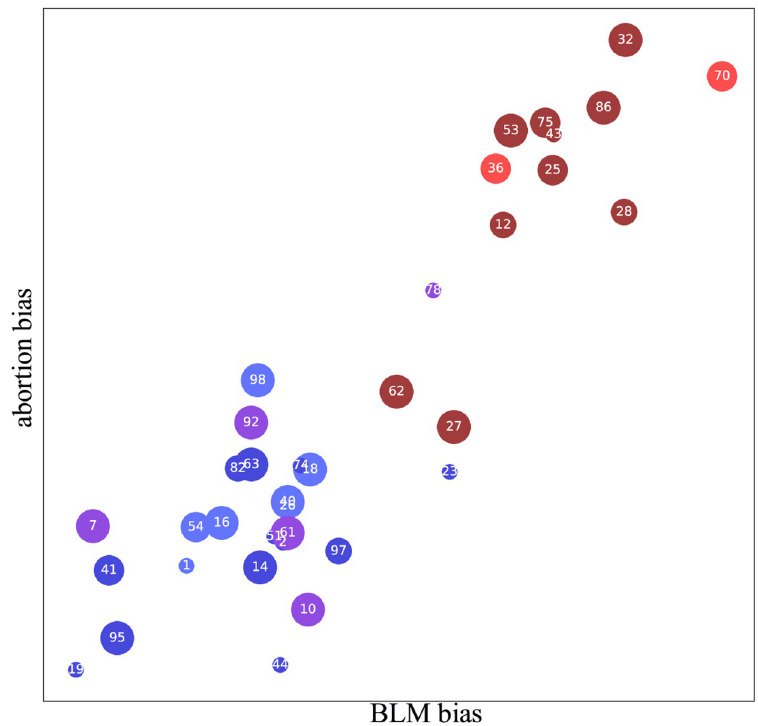
Fig 5. BLM bias (the x -axis in Fig 1) and abortion bias (the x -axis in Fig 4) are seen to be highly correlated. Each dot corresponds to a newspaper (see legend in Fig 2).